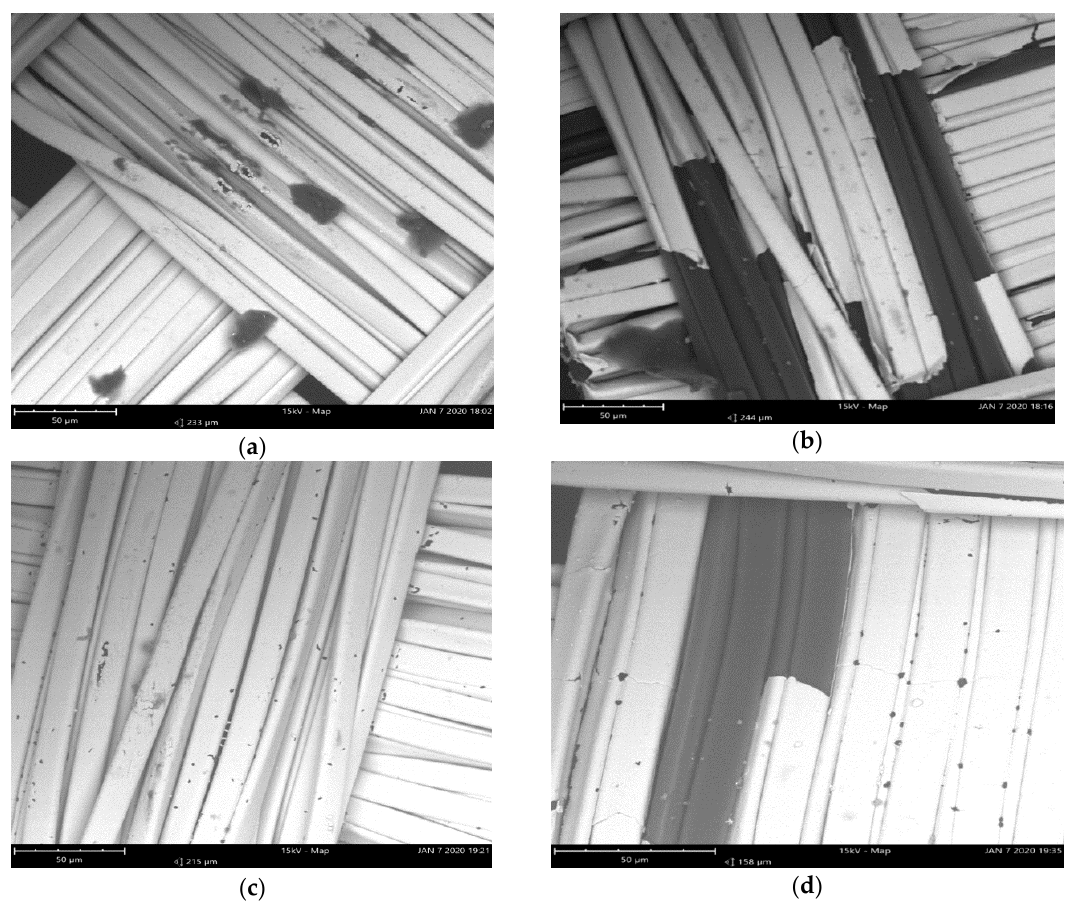
Figure 9. SEM analysis, ( a ) F3 before wash ( b ) F3 after wash ( c ) F2 before wash ( d ) F2 after wash.